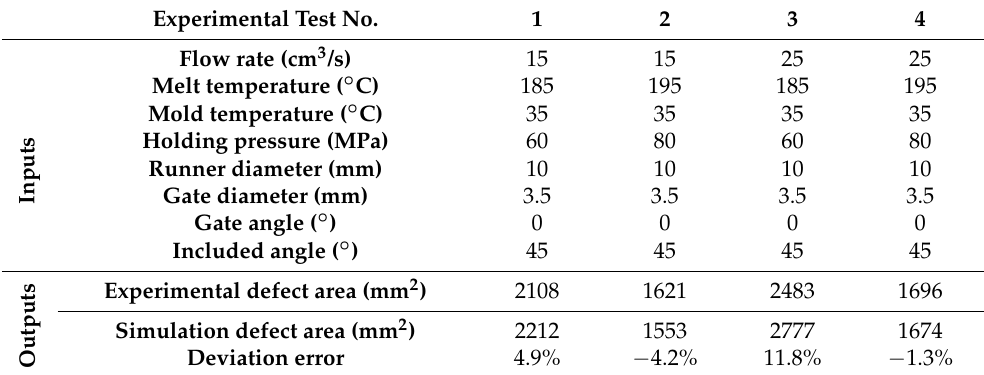
Table 3. Validation of FEA.